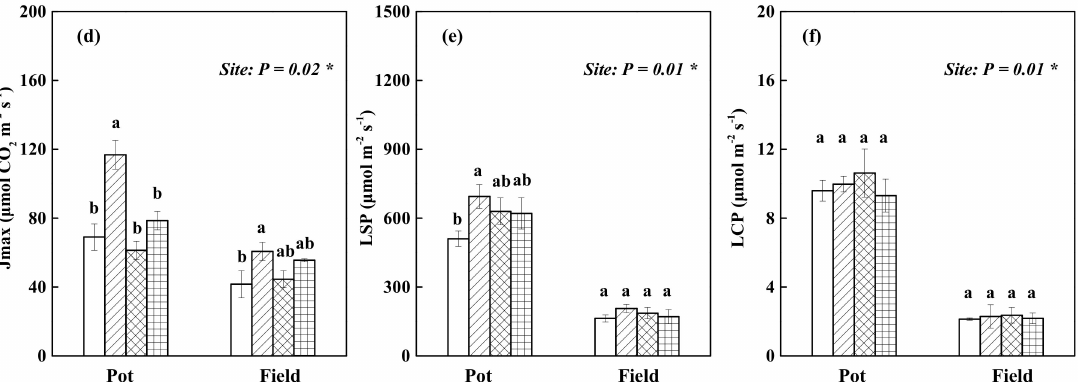
Figure 1. Leaf light-saturated photosynthetic rate (P max ) ( a ), water use efficiency (WUEi) ( b ), the maxi- mum rate of carboxylation (V cmax ) ( c ), the maximum rate of electron transport (J max ) ( d ), light saturate point (LSP) ( e ), and light compensation point (LCP) ( f ) of Schima superba under field and pot experi- mental nitrogen and phosphorus addition (CK = control, +N = nitrogen addition, +P = phosphorus addition, +NP = nitrogen plus phosphorus addition). Note: The bars indicate the standard error. The small letters indicate the differences ( p < 0.05) among the four treatments within field or pot experiments. The p value indicates the difference ( p < 0.01, **; p < 0.05, *) between field and pot experiments. The bars indicate standard errors (field, n = 3; pot, n = 6).